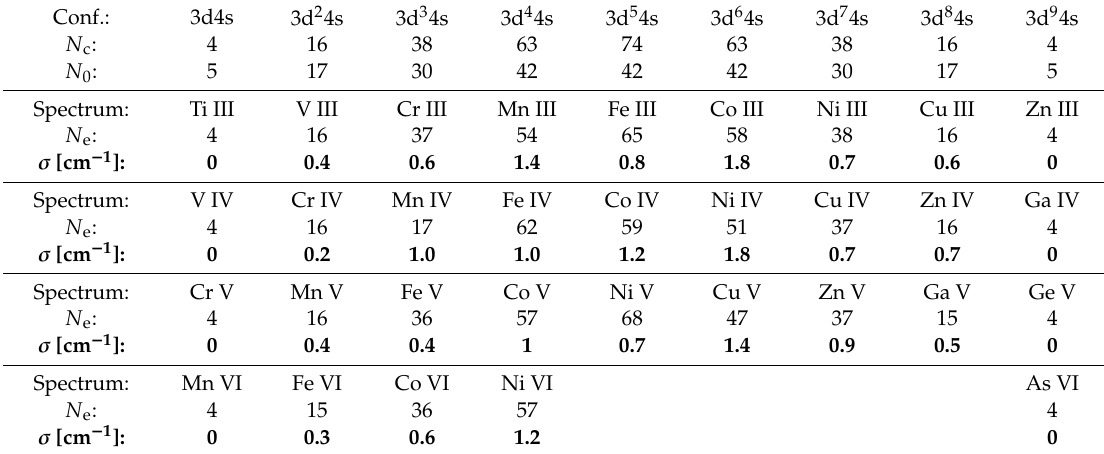
Table 1. Survey of the 3d n 4s configurations investigated using orthogonal